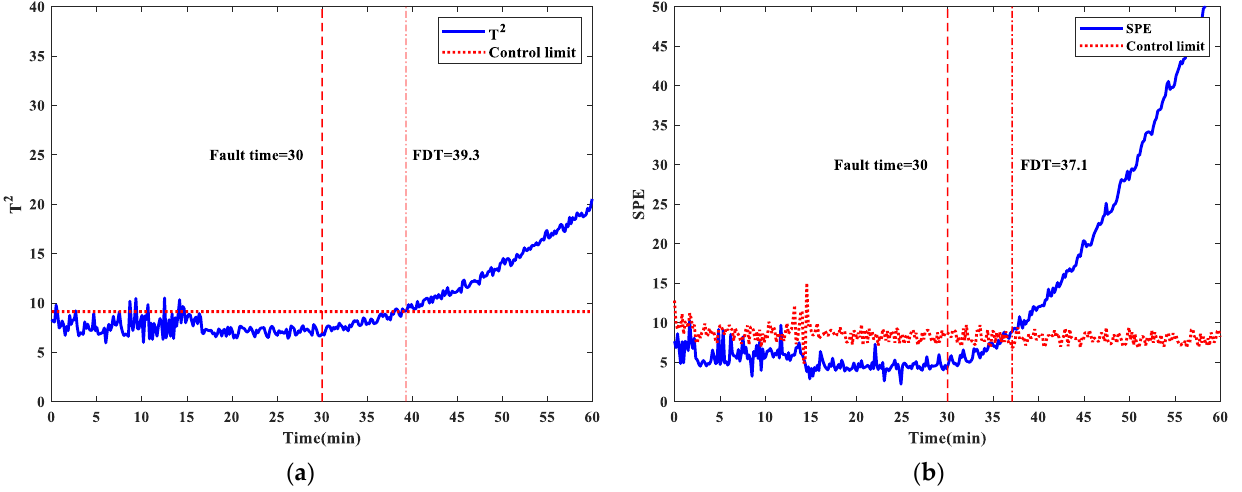
Figure 5. Fault monitoring charts of F2 based on MI-MPCA: ( a ) 𝑇 2 monitoring chart; ( b ) SPE monitoring chart.